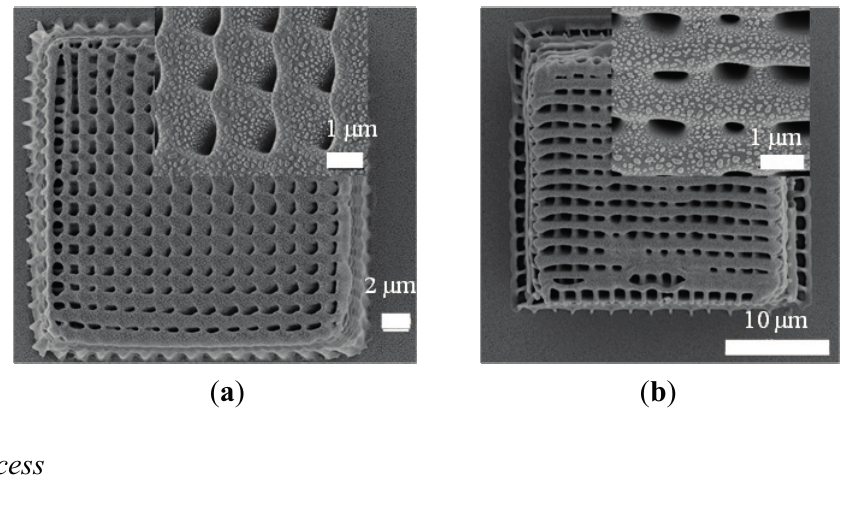
Figure 10. SEM images of structures of in-situ prepared polymer/nanoparticles composites produced by 2PP after thermal treatment for 2 h at 250 °C at ( a ) 0.16 wt % and